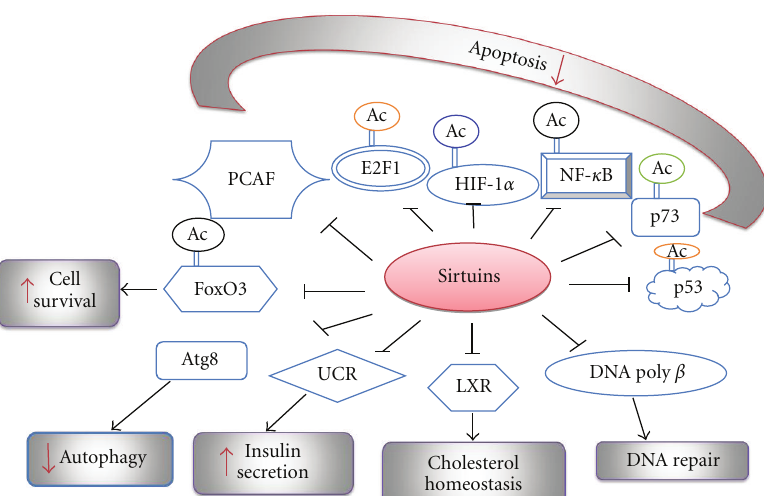
Figure 3: Sirtuins regulate the activity of numerous transcriptional regulators indirectly a ff ecting the outcome of several cellular